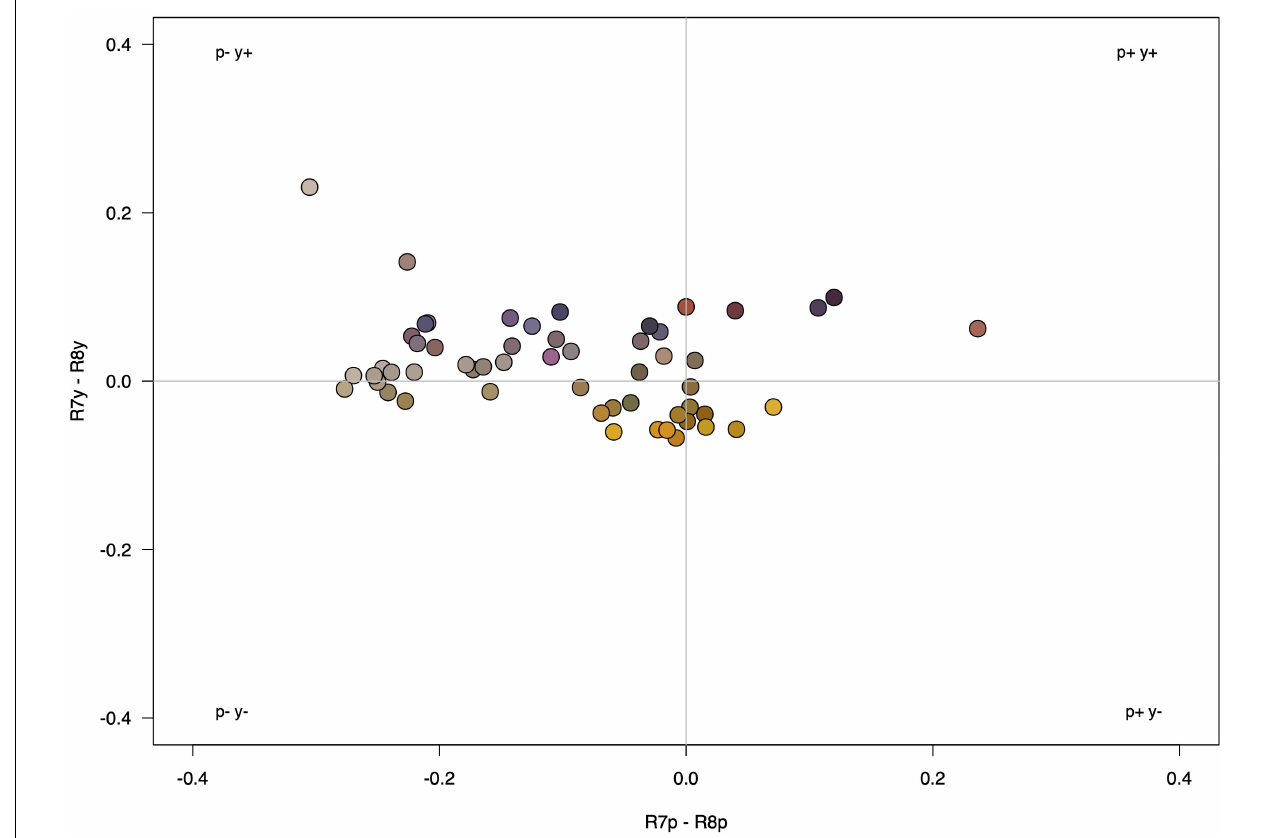
FIGURE 3 | Fly color space depicting differential stimulation of color photoreceptor types of Eristalis tenax . Color of circles represents human-perceived color of flowering structure for each species.